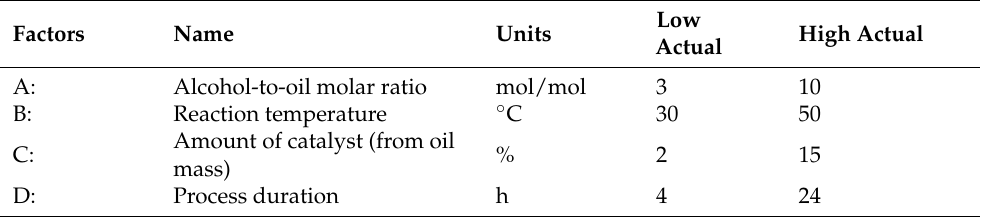
Table 1. Independent variables and levels used for CCD in transesterification of salmon oil with